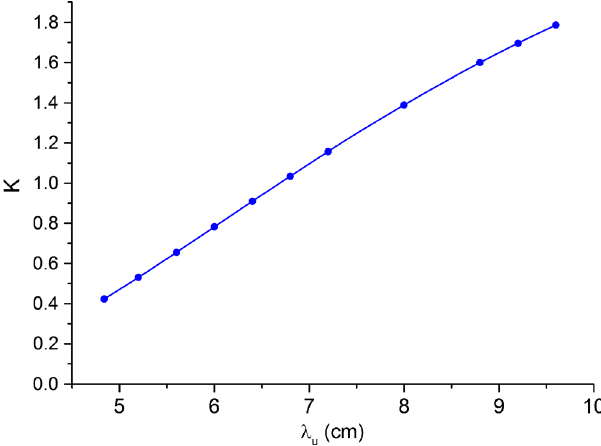
FIG. 9. Third harmonic of undulator magnetic field normalized to first harmonic